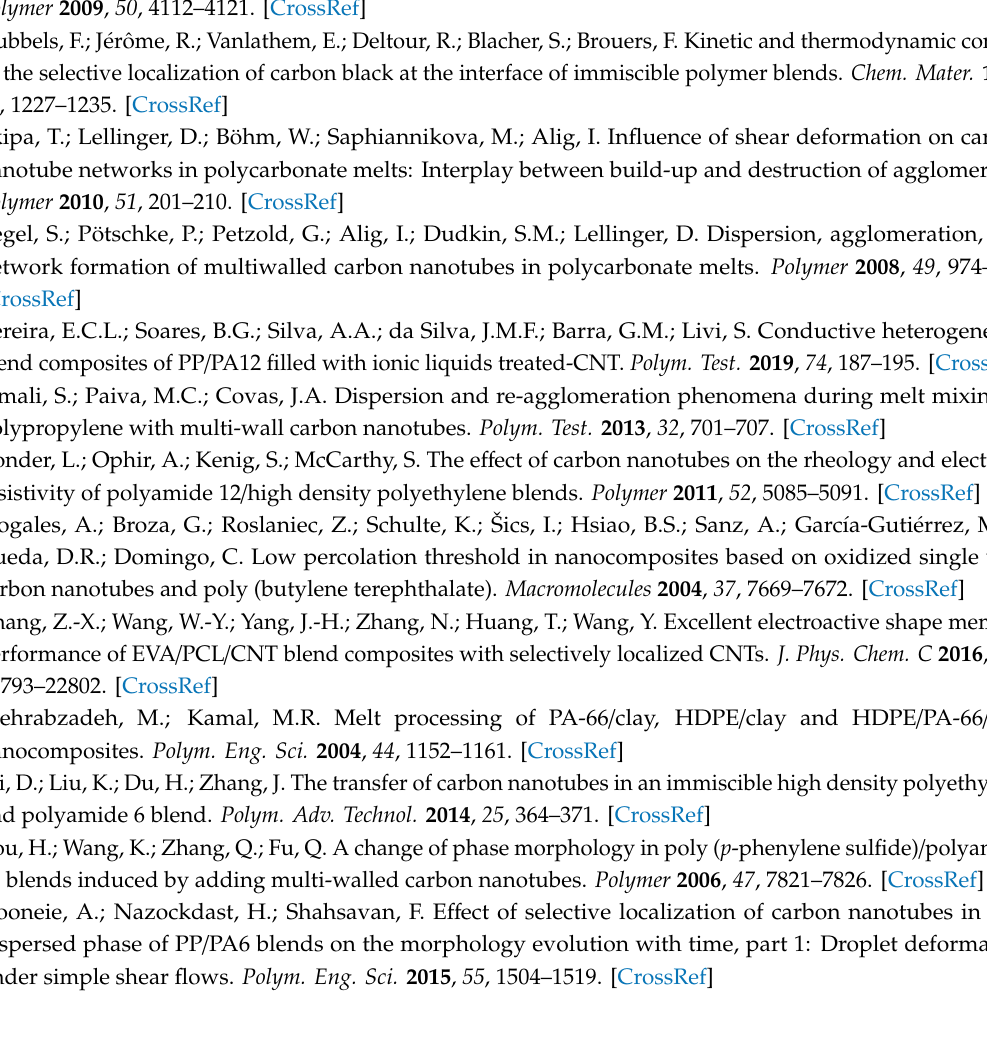
Figure S1: Selective stress-strain curves of di ff erent samples molded by (a) CIM, (b) MFVIM, and (c)